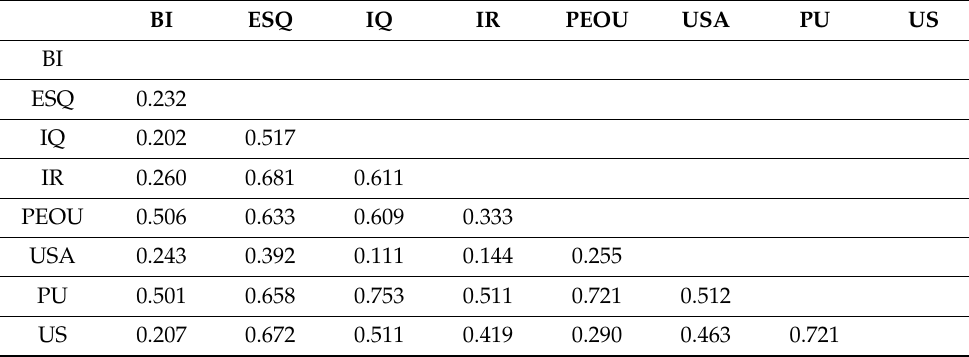
Table 7. Heterotrait–Monotrait Ratio